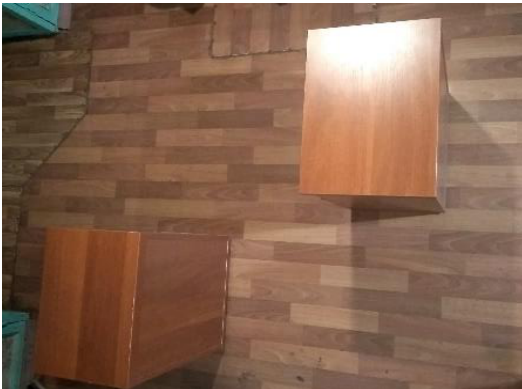
Fig. 8. A test case for our system (a real-world photo)